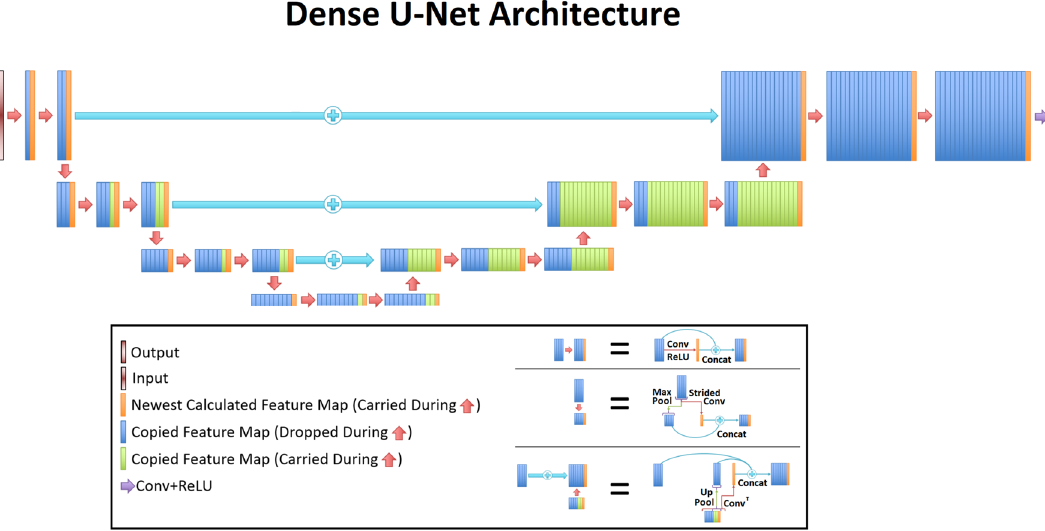
Figure 3. The densely connected U-Net architecture from a previous publication 38 is displayed. The densely connected flavor of this model allows for important features to be carried over throughout the entire training